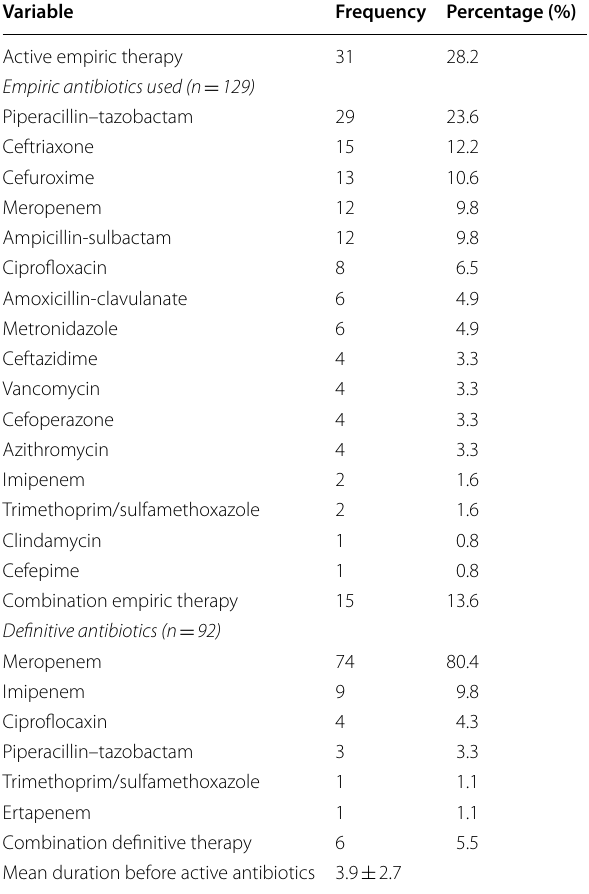
Table 4 Antibiotics used for empiric and definitive therapy among the